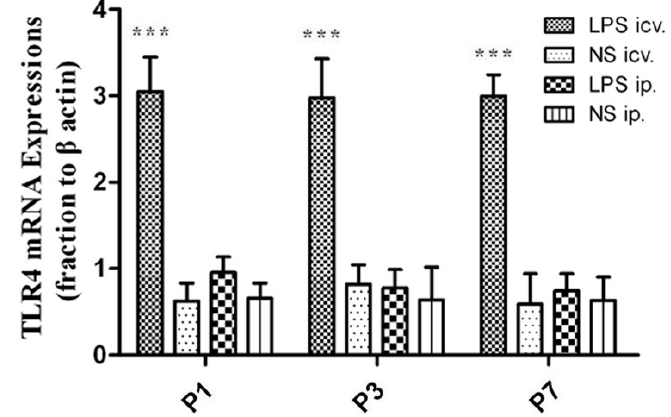
Figure 4. The expression of TLR4 mRNA in the neonatal rat brain. At all ages detected, icv. injection of LPS induced dramatic increase in TLR4 mRNA expression ( *** p < 0.001), compared with that in the peripheral LPS, central NS and peripheral NS injection groups. No significant difference was found in the TLR4 mRNA expression in the neonatal rat brains between ip. injections of LPS and